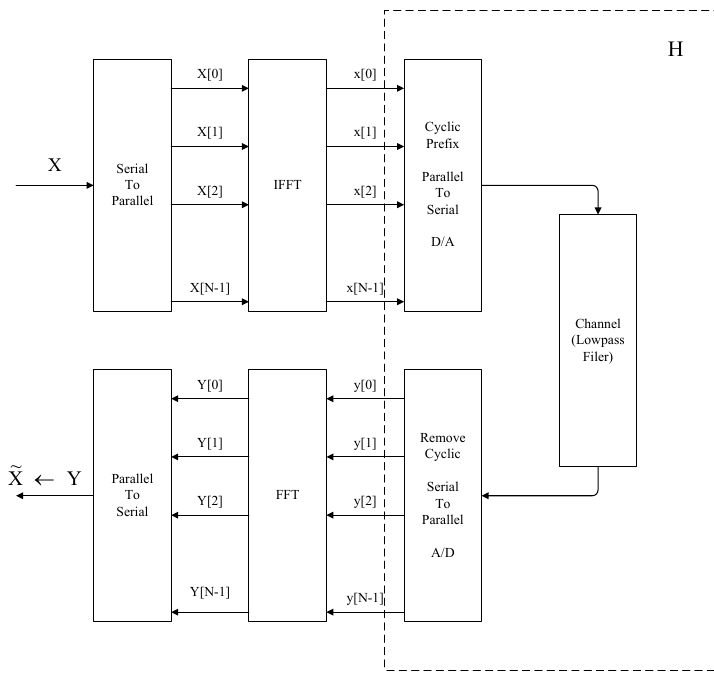
Figure 3. Orthogonal frequency-division multiplexing